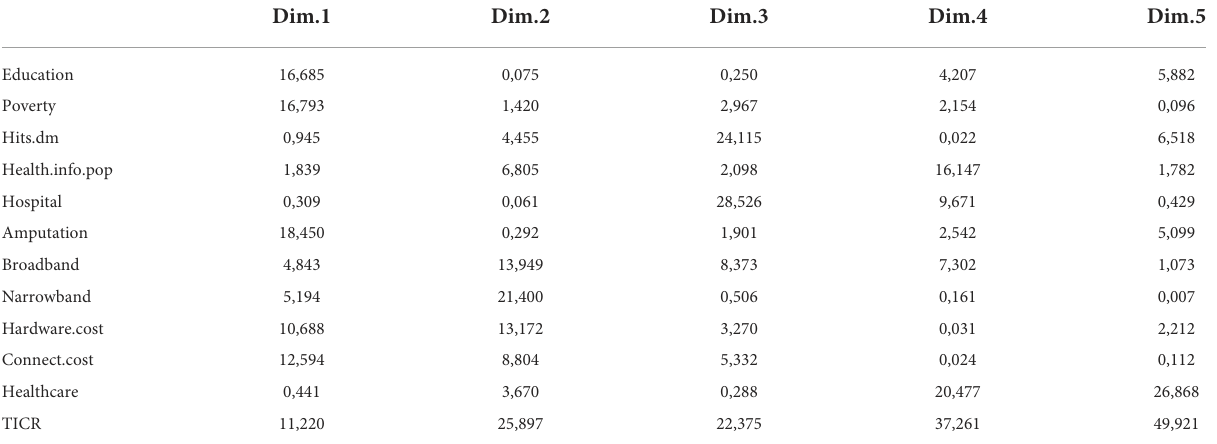
TABLE 6 Contributions to the dimensions of DM and the SDOH variables. Dim.1 Dim.2 Dim.3 Dim.4